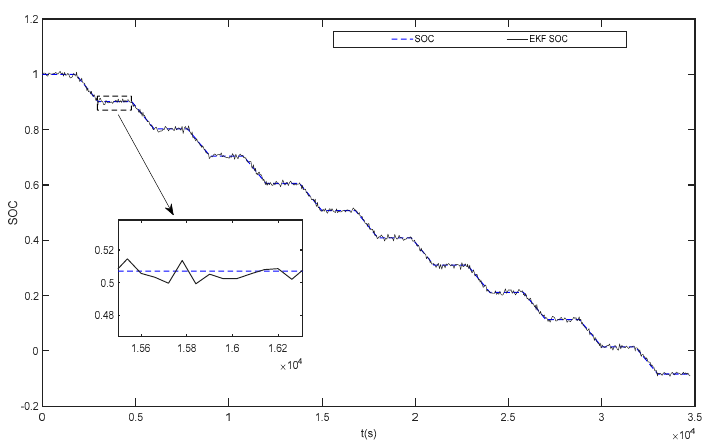
Figure 13. Comparison of Extended Kalman filter (EKF) with proposed SOC estimation under regular pulse discharge test.